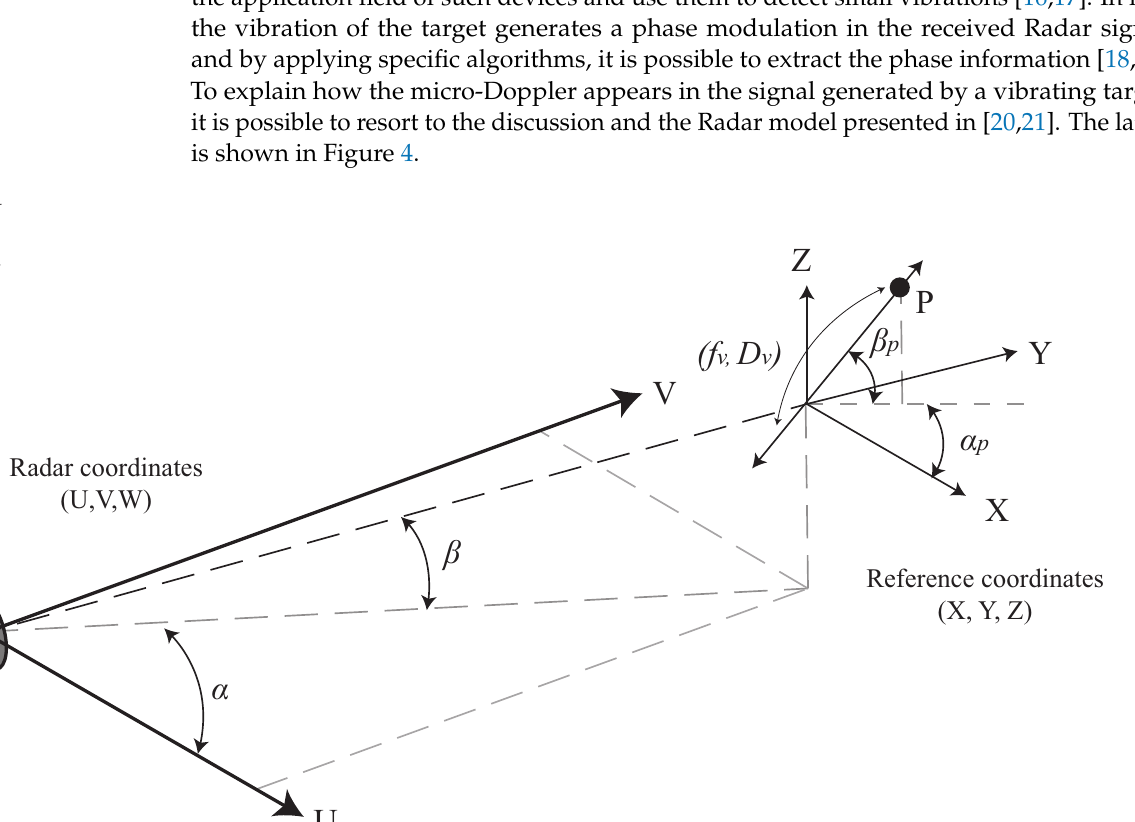
Figure 4. Geometry for the Radar and a vibrating point target. The Radar is situated in position Q, and the target is in